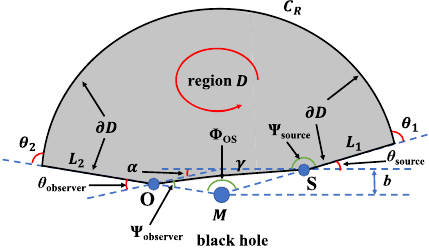
Fig. 5 Calculating the gravitational deflection angle for finite distance using Gauss–Bonnet theorem. This figure shows the choice of region D in the equatorial plane of optical manifold in cases where particle source (labeled by S ) and observer (labeled by O ) are both located at finite distance region. This region D would make the application of Gauss–Bonnet theorem in Eq. (10) available. The direction of boundary (cid:17) ∂ D in contour integral κ g dl is chosen to be counterclockwise. Note ∂ D that for the particle orbit γ , this choice of direction (which is from O to S ) is opposite to the propagation of particles. In this figure, (cid:21) source and (cid:21) γ and the radial direction, observer are the angles between particle orbit which are exactly the same as the definition in Ishihara’s work [47]. The angle φ OS = φ observer − φ source is the change of azimuthal angle. After these definitions, the gravitational deflection angle for finite distance can be expressed as α finite distance = (cid:21) source − (cid:21) observer + φ